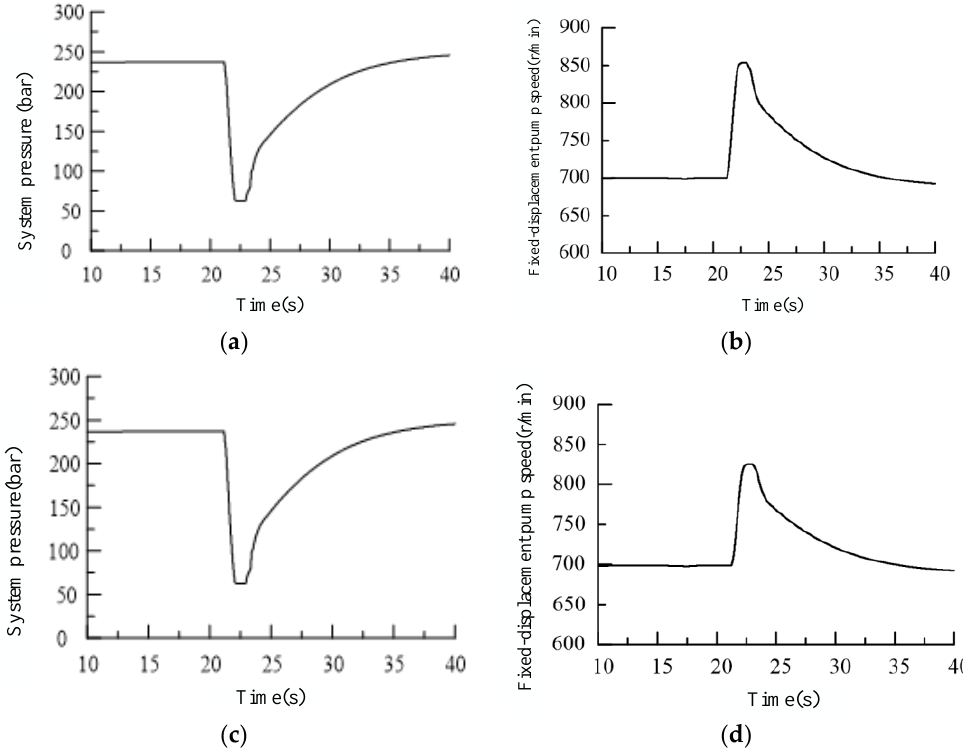
Figure 11. Simulation curve of HWT voltage drop when applying mid-level control. ( a ) System pressure simulation curve when single-phase drops 80%; ( b ) Quantitative pump speed simulation curve when single-phase drops 80%; ( c ) System pressure simulation curve when three-phase drops 20%; ( d ) Fixed-displacement pump speed simulation curve when three-phase drops 20%.